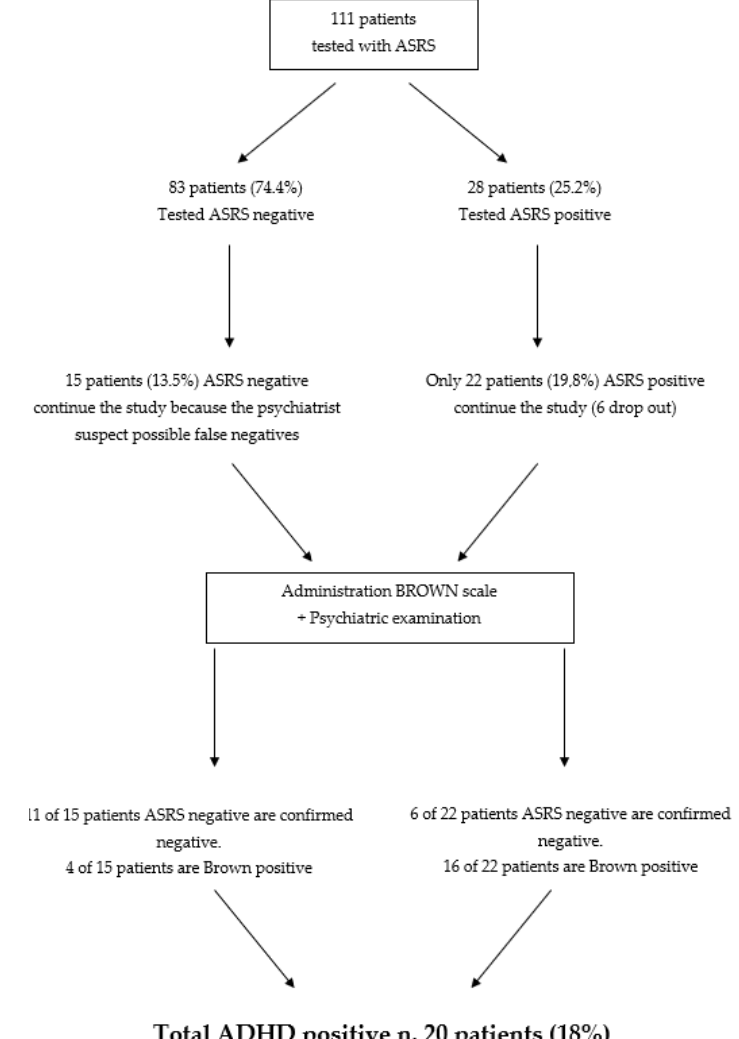
Figure 1. Study Scheme and Results. (Figure 1: Scheme of study and results. The figure shows the scheme of this work: it began with the administration of the ASRS to 111 patients. Then, two groups, the suspected false-negative ASRS group and the positive ASRS group, continued on to the administration of the Brown scale. The results are shown; the numbers and percentages of the patients are also